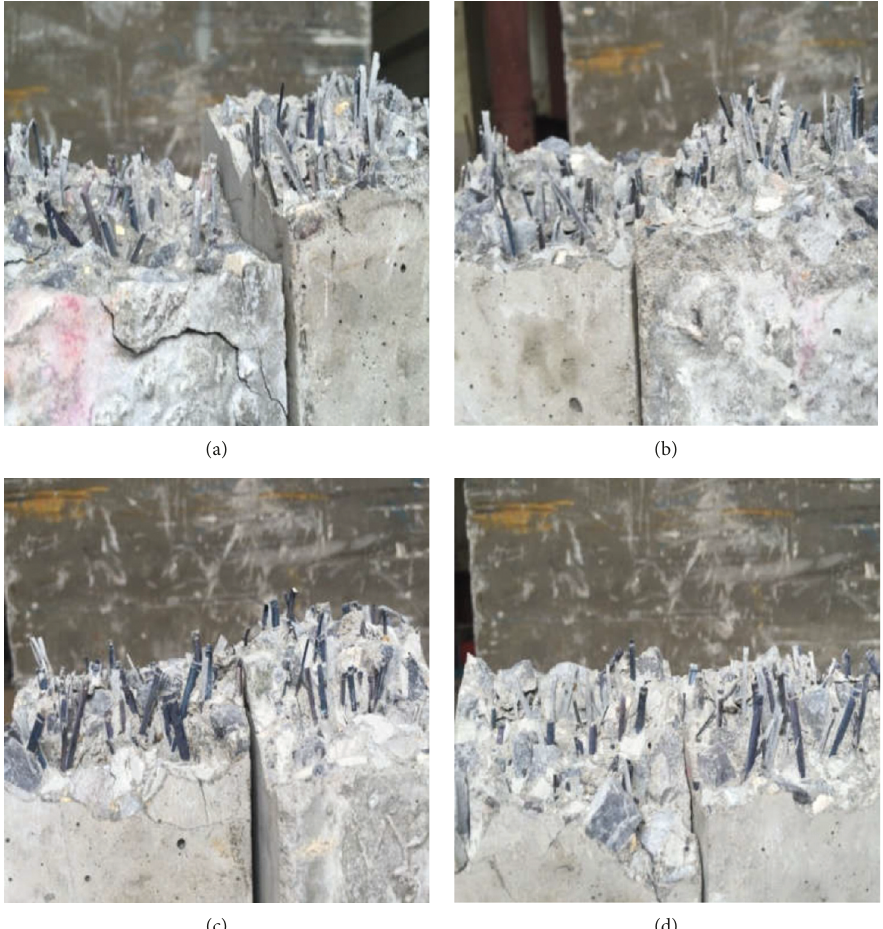
Figure 14: Cross section of a directionally distributed steel fibre-reinforced concrete beam. (a) Number 2a. (b) Number 2b. (c) Number 2c. (d) Number 2d.